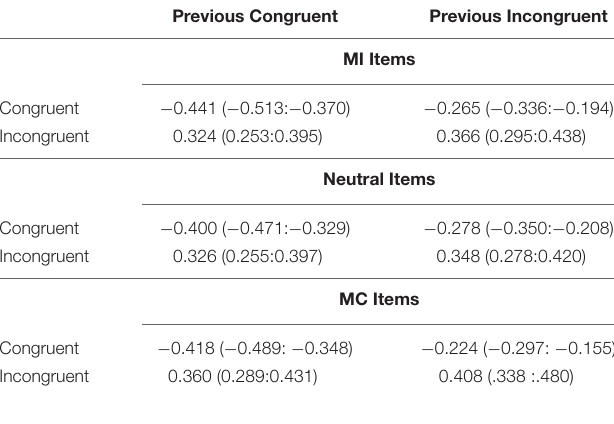
TABLE 2 | Mean z -scored RTs (and HDIs) for each condition in the CSE analysis of Experiment 1. Previous